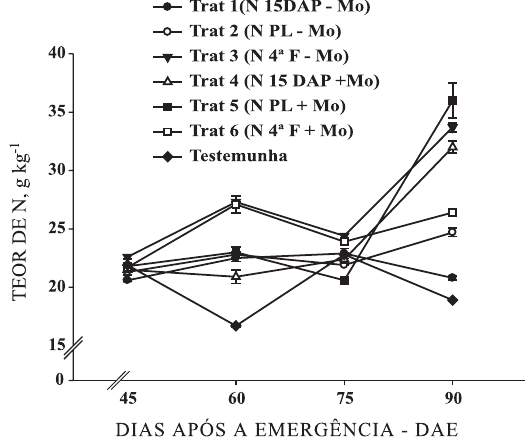
Figura 2. Teor de nitrogênio na folha de milho em função das épocas de aplicação de N e no suprimento de Mo na cultura do milho. Barras verticais: intervalo de